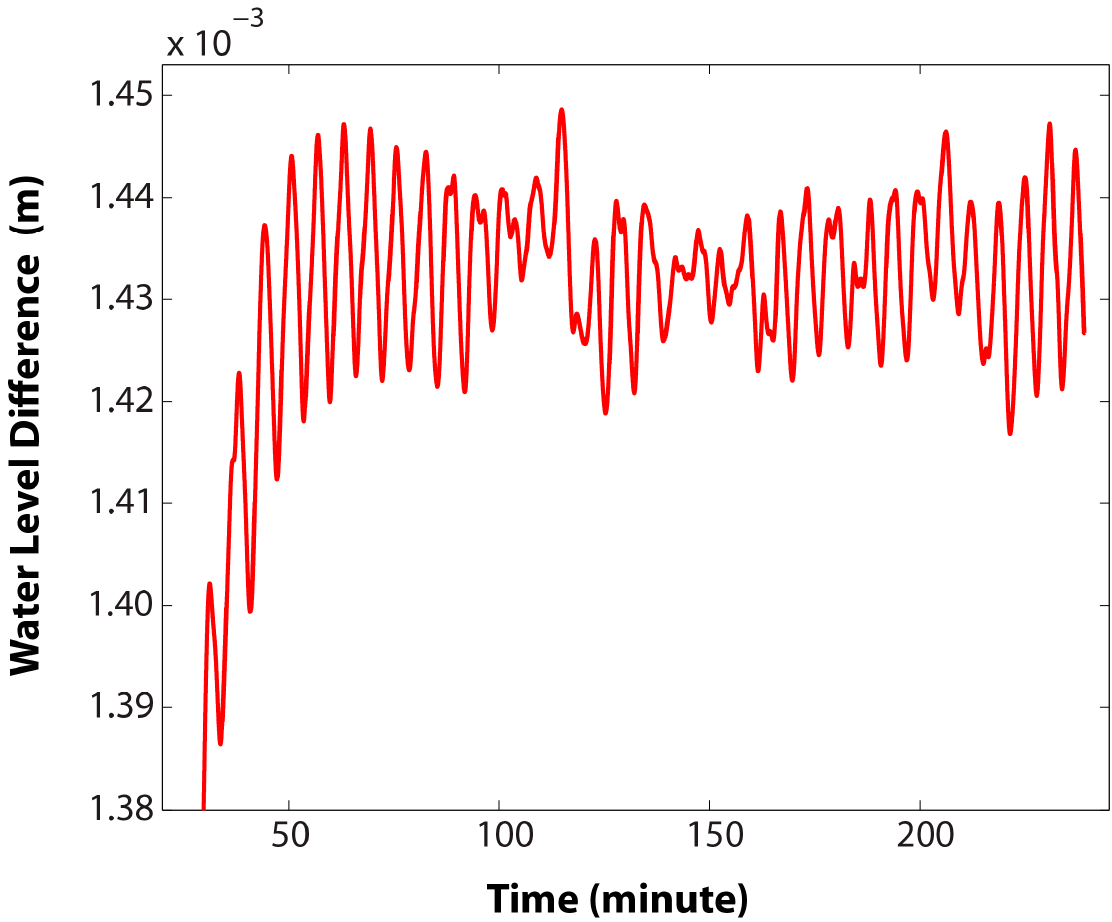
Figure 5. Water level difference between the two positions (blue circles in Figure 1) under the force of constant zonal wind selected in FVCOM simulation.